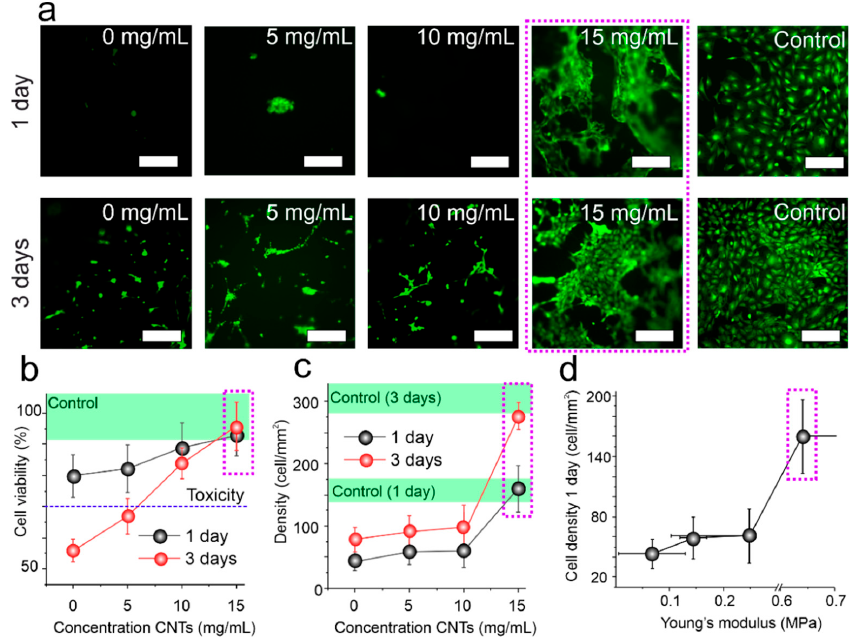
Figure 4. ( a ) Fluorescence microscopy images of MC3T3-E1 cells on GG-CNTs hydrogels surface. Cells on the the surface of a plastic cell culture dish are present as a control. Scale bars correspond to 250 μ m. ( b ) Cell viability on GG-CNTs hydrogels as a function of the concentration of CNTs. ( c ) The number of cells adhered to the surface of the samples after 1 and 3 days of incubation as a function of the concentration of CNTs. ( d ) Cell density after 1 day of incubation versus Young’s modulus of GG-CNTs.